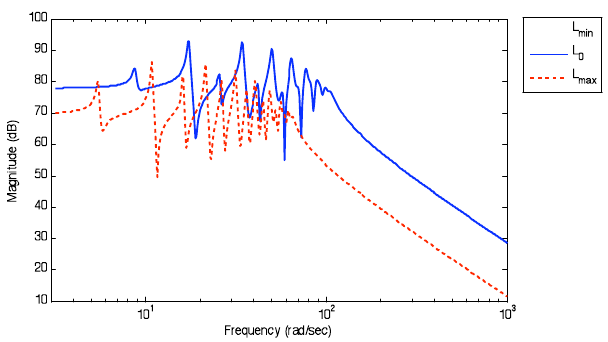
Fig. 5. Bode diagram of for different web span lengths